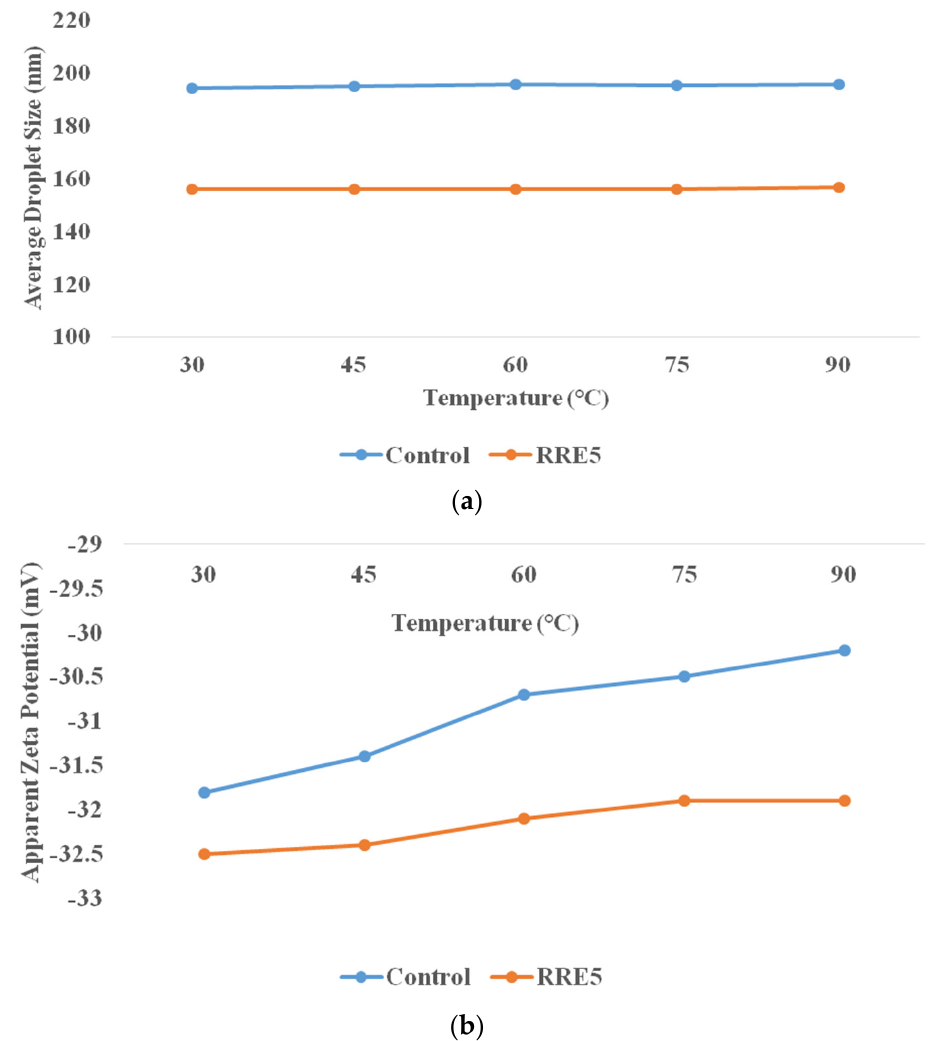
Figure 4. ( a ) Effect of temperature on average droplet size, ( b ) effect of temperature on zeta potential. Data are presented as means ± SD ( n = 3).